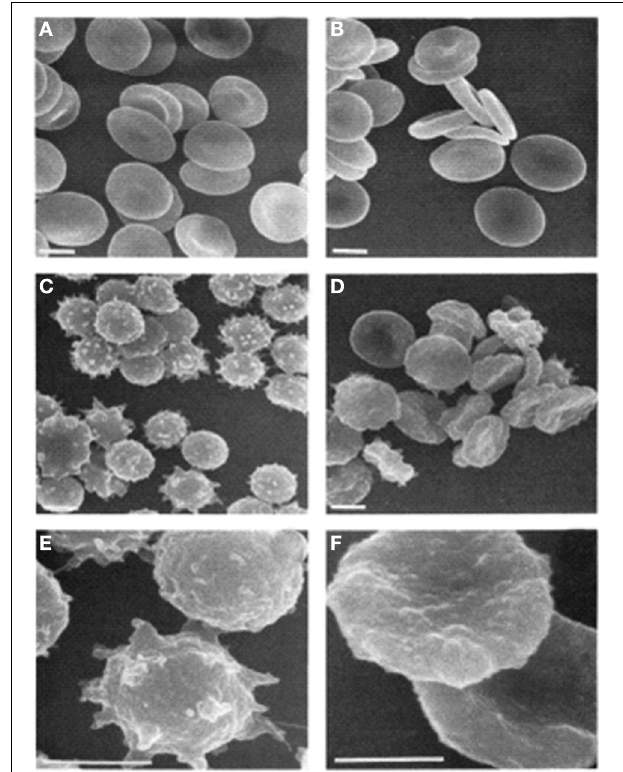
FIGURE 2 | Scanning electron micrographs of RBCs. (A) Untreated control; (B) untreated Scott syndrome; (C,E) A23187-treated control; (D,F) A23187-treated Scott syndrome. Bar indicates 3 µ m. Magnification in (E,F) is three times higher than in (C) through (D) . Cells were fixed 1h after addition of ionophore. Reprinted from Bevers et al. (1992), with permission from